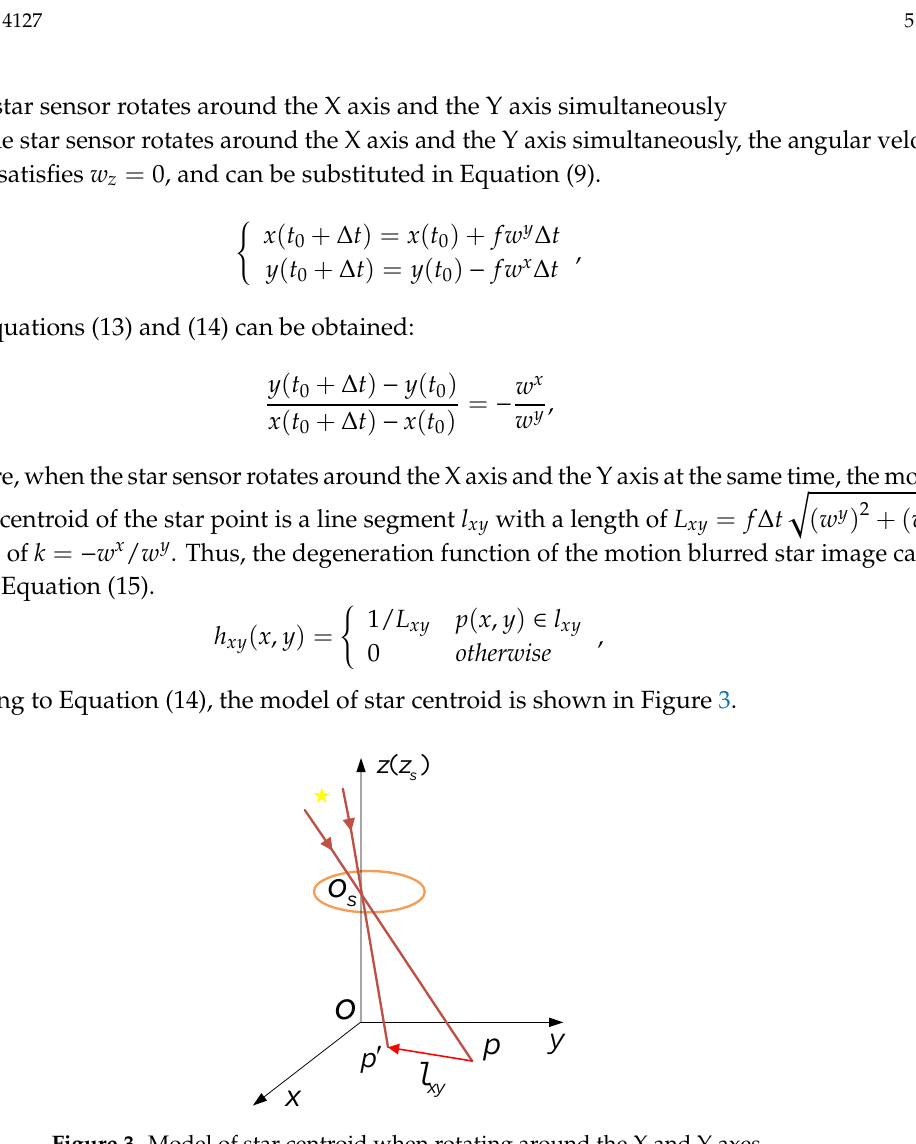
Figure 3. Model of star centroid when rotating around the X and Y axes.